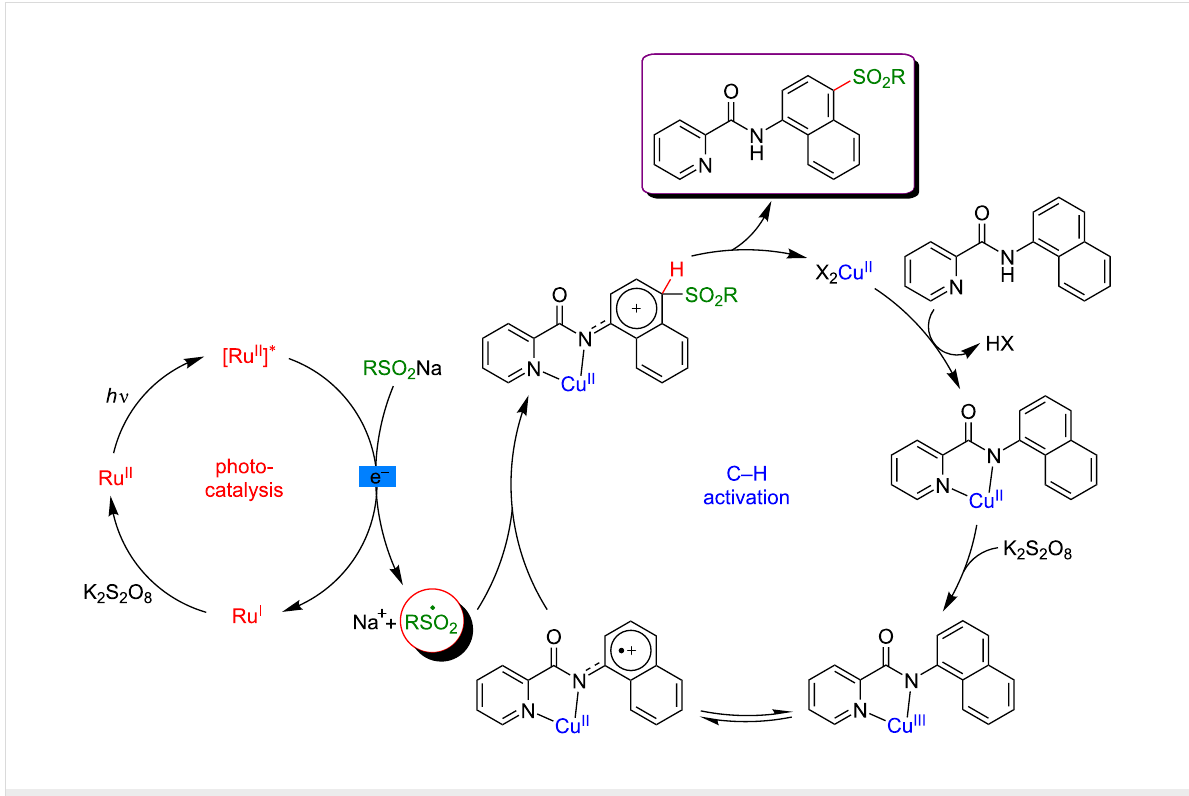
Figure 36: Proposed mechanism for sulfonylation of 1-naphthylamides via dual catalysis.